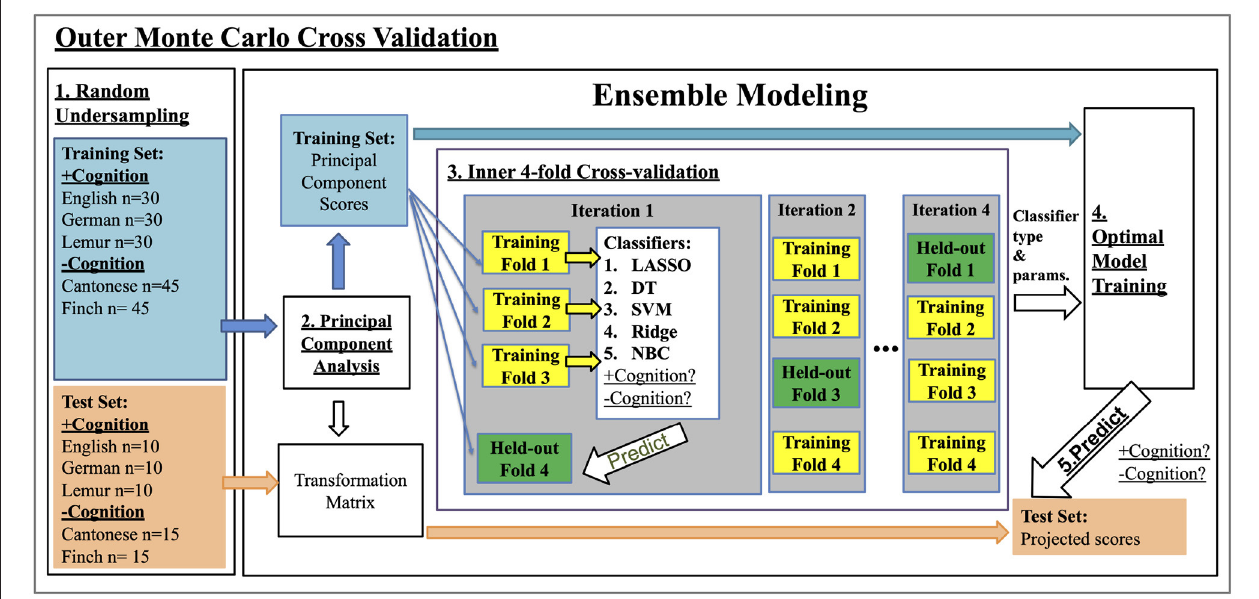
FIGURE 1 | Nested Cross Validation Schema: training classifiers to classify +cognition vs. -cognition vocalizations. Step 1: In each of the 100 outer Monte Carlo Cross Validation iterations, we used an undersampling procedure to randomly select a total of 240 vocalizations from those that do (+cognition) and do not (-cognition) support cognition. Each type of vocalization was represented equally within the two classes (i.e., 60 Cantonese, 60 Zebra Finch vocalization, 40 English, 40 German, and 40 lemur vocalization samples). The 240 samples were then split into training and test sets with stratified sampling in a 75:25 ratio. Step 2: A principal component analysis (PCA) was performed on the input acoustic features (see Section 2.2) of the training set. Principal components (PCs) with scores that collectively explain 95 % of total variance of the training set were selected as training features. Acoustic features from the test set were transformed into PC scores using the PCA transformation matrix calculated on the training data only. Step 3. An inner four-fold cross-validation procedure was performed to selected the optimal classifier type and parameters. We divided the training set into four-folds, and trained different combinations of classifier type and parameters using three out of the four folds of the data. The resulting models were validated on the remaining held-out fold. The process was repeated for four iterations with a different heldout fold each time. The combination of classifier type and parameters that achieved the highest accuracy in the inner cross-validation were selected as optimal. Step 4: The optimal classifier and parameters were then used for training on the whole training set. Step 5. The model from Step 4 was validated by predicting the +cognition or -cognition labels of the test set from step 1, after being transformed in step 2. The numbers calculated in Step 5 are reported in Table 2 .